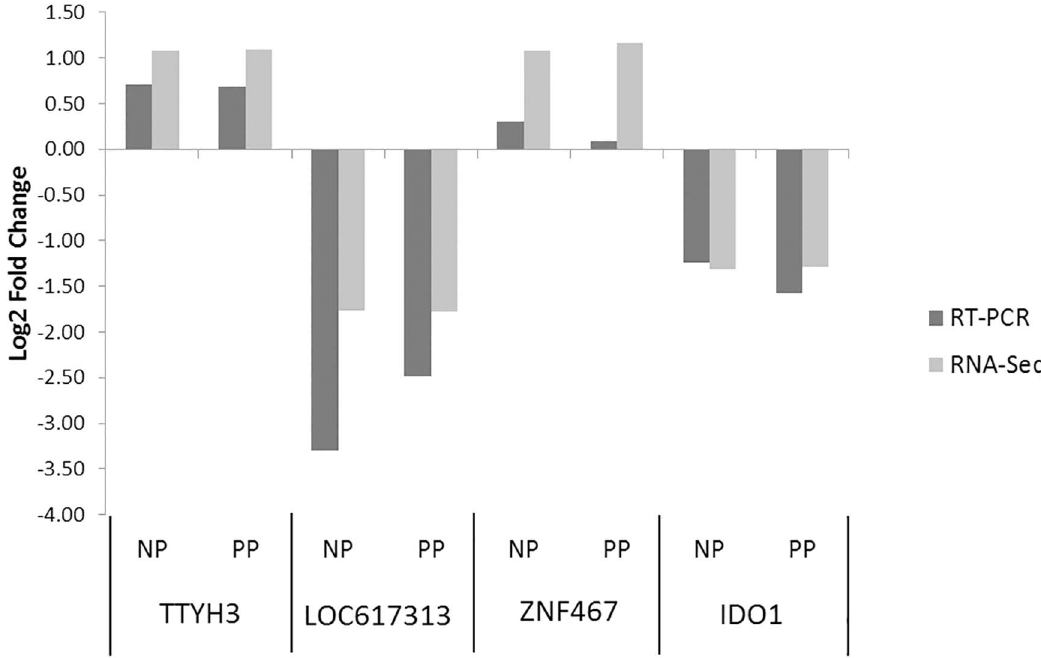
Fig 2. Validation of RNA-Seq data with qRT-PCR assays. Relativequantificationwas calculated with respect to the control group, after normalization with ACTB and GAPDH expression levels.